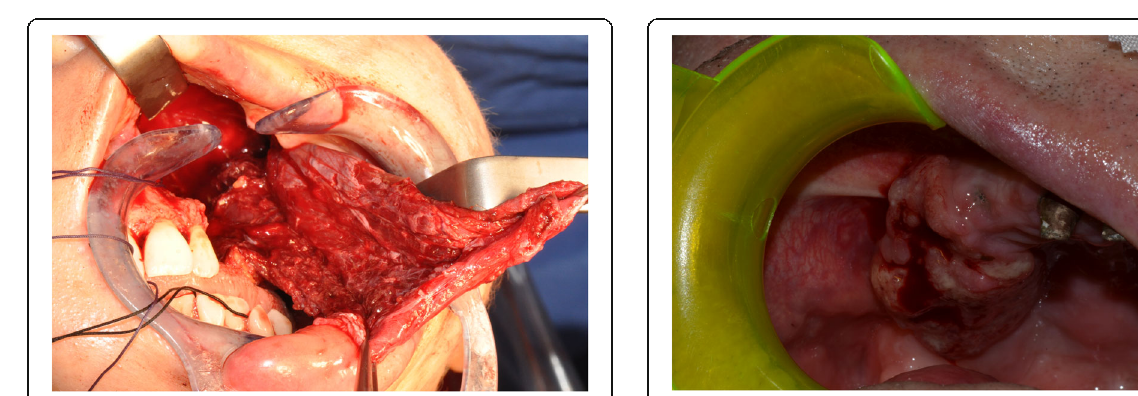
Fig. 12 Pt no. 3. Ulcerated SCC of the right upper gingiva